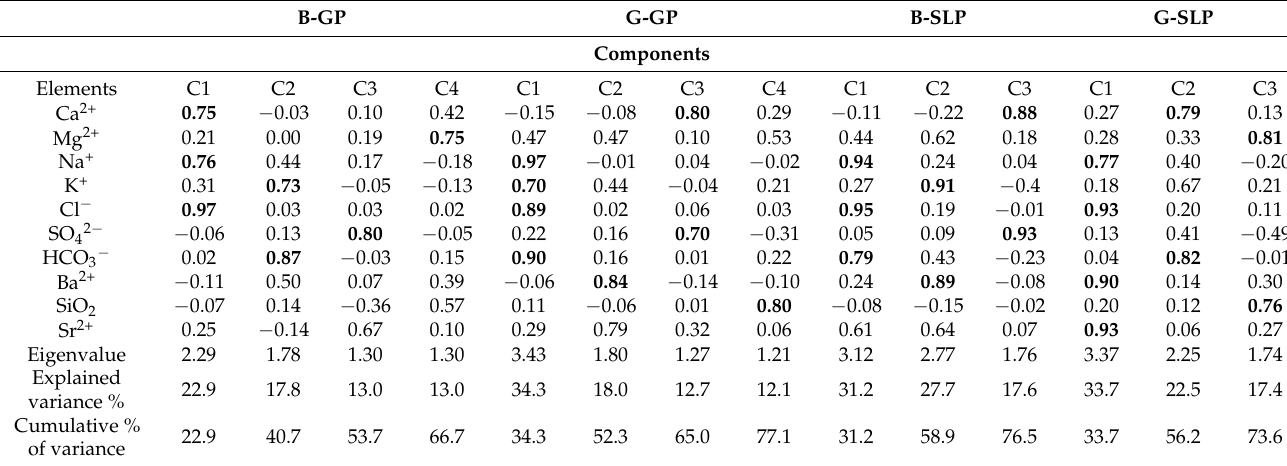
Table 3. Principal component loadings and explained variance for the four groups separated by geological provinces and aquifer types. Bold values indicate a loading > 0.70; a threshold applied for establishing significance. GP, Grenville